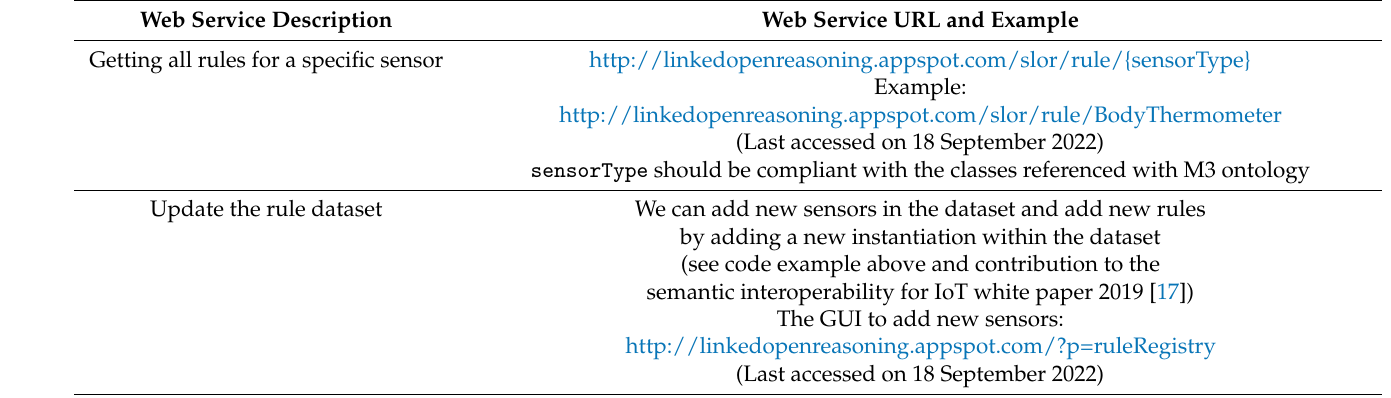
Table 5. Specification draft of the S-LOR Knowlege Reasoning